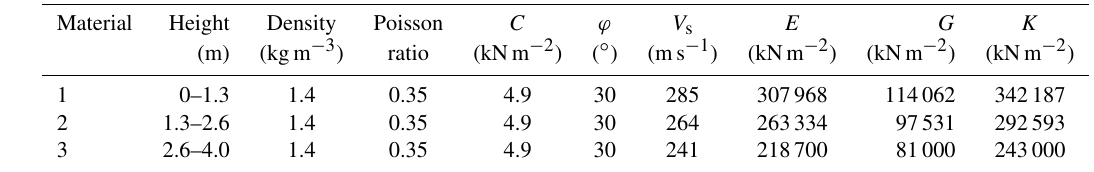
Table 6. Embankment characteristics.